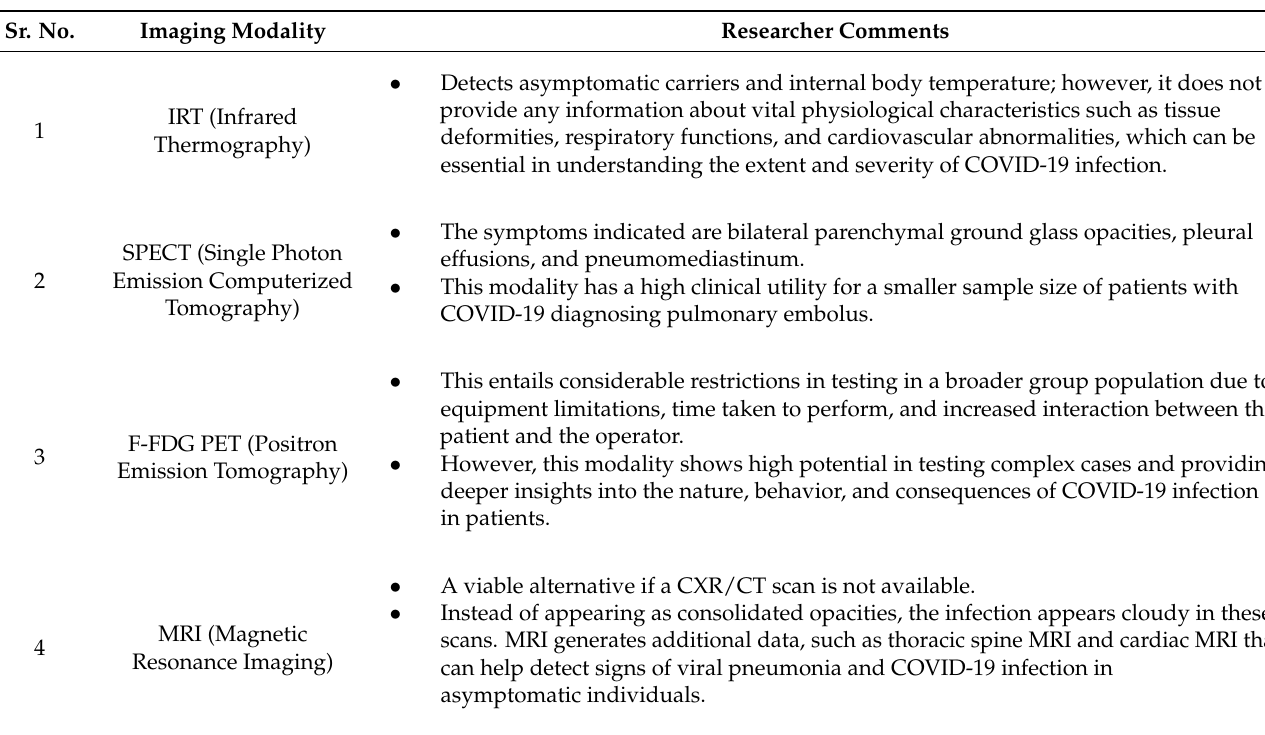
Table 4. Potential bio-imaging modality inputs for CNN